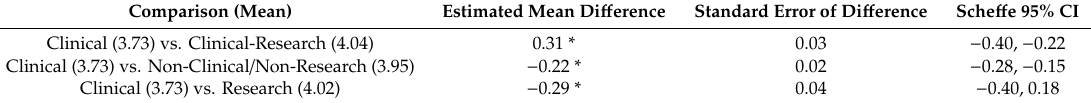
Table 4. Comparisons of mean di ff erences in burnout (reverse coded) by department type.